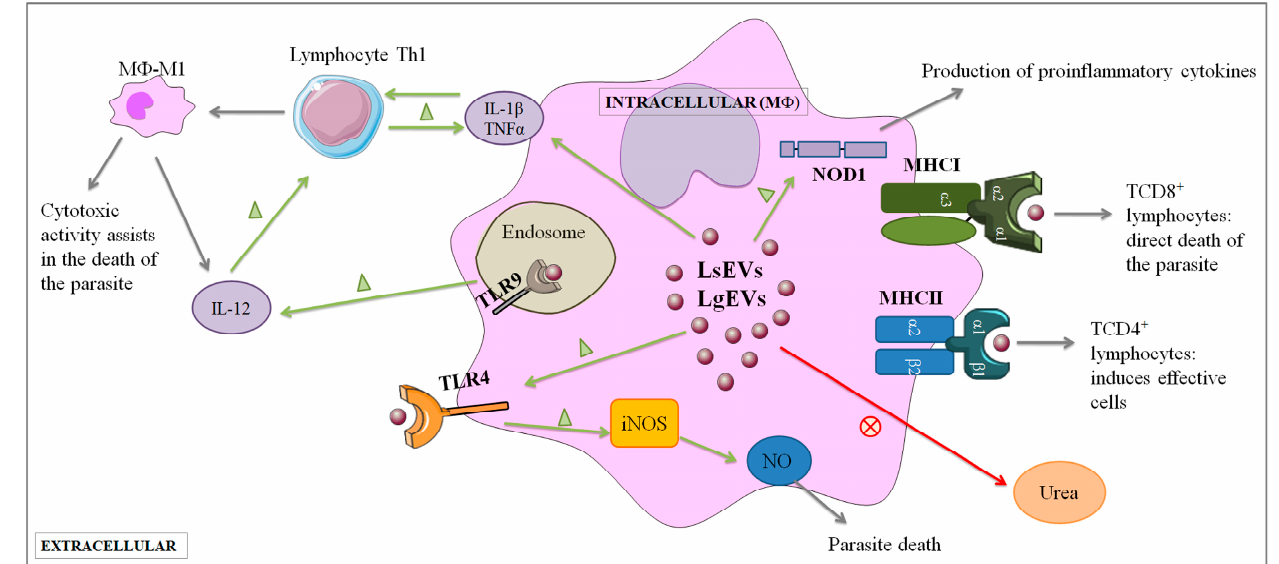
Figure 12. Proposed model for the interplay of Leishmania EVs with macrophages. EVs shed by L.